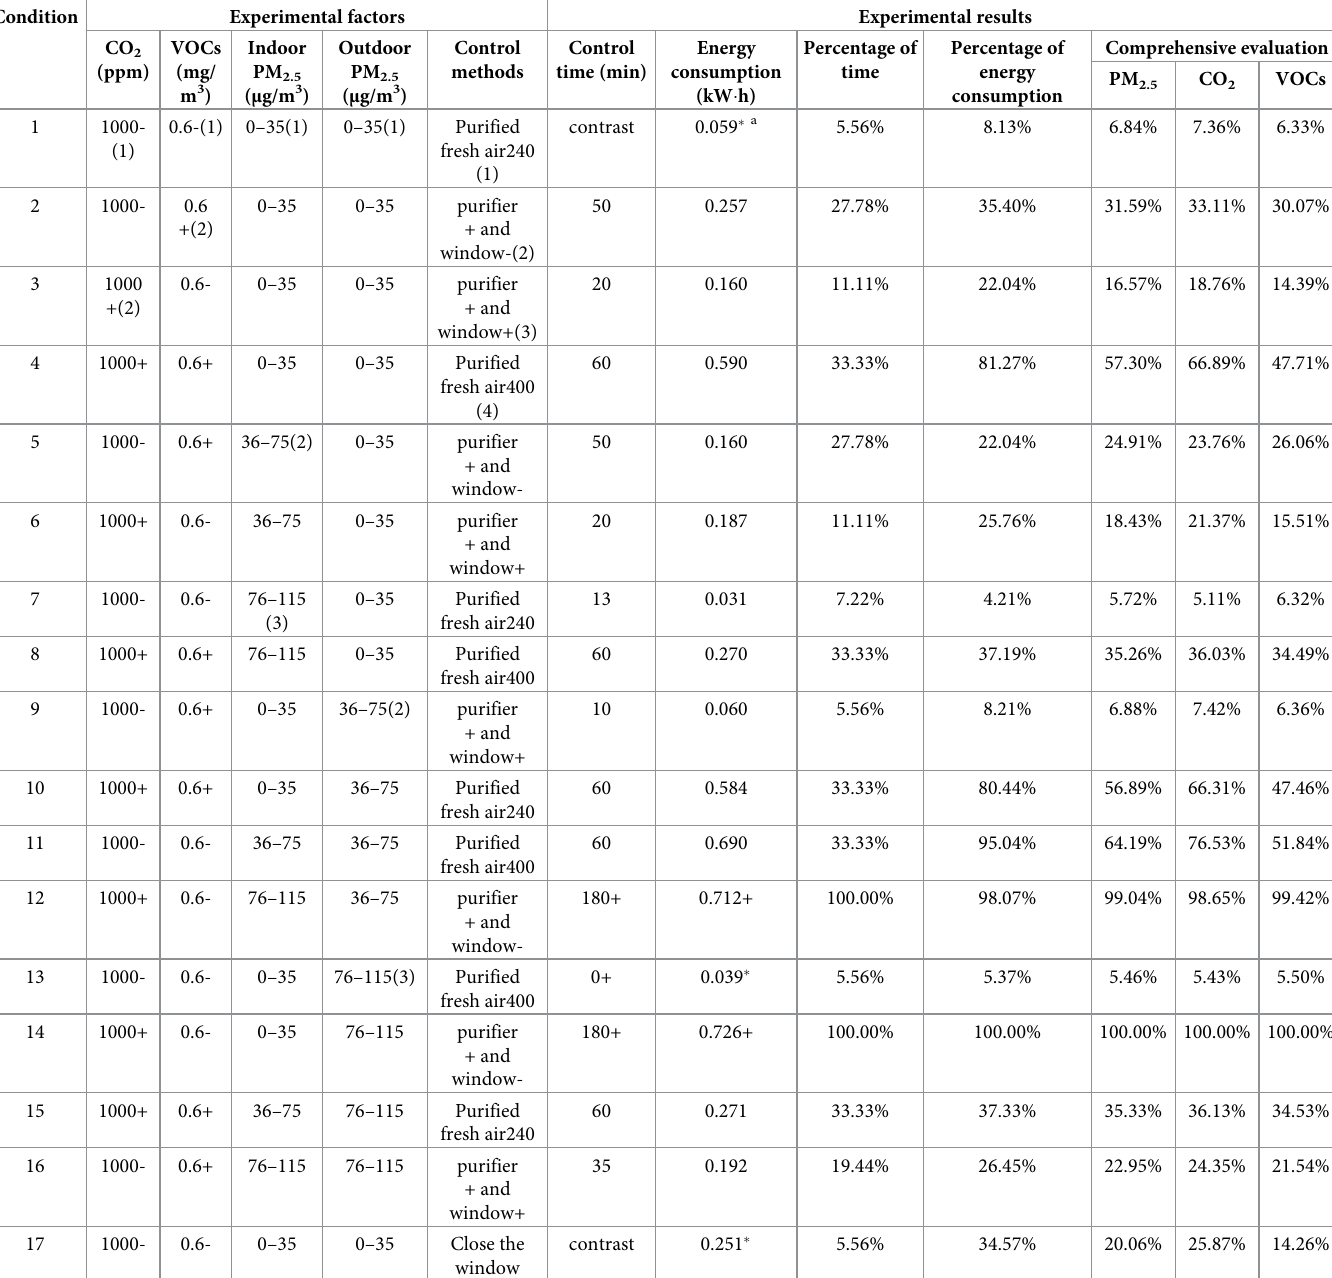
Table 1. Orthogonal experiment condition and comprehensive evaluation